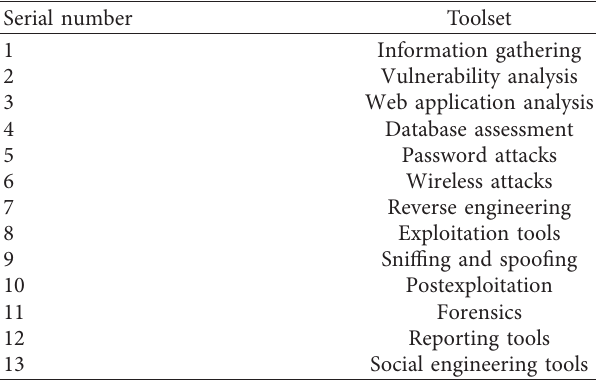
Table 1: Kali Linux